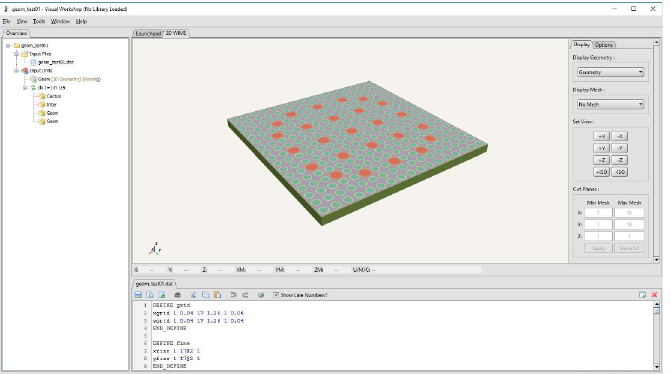
Figure 1. Example Visual Workshop Display Showing 3D Geometry